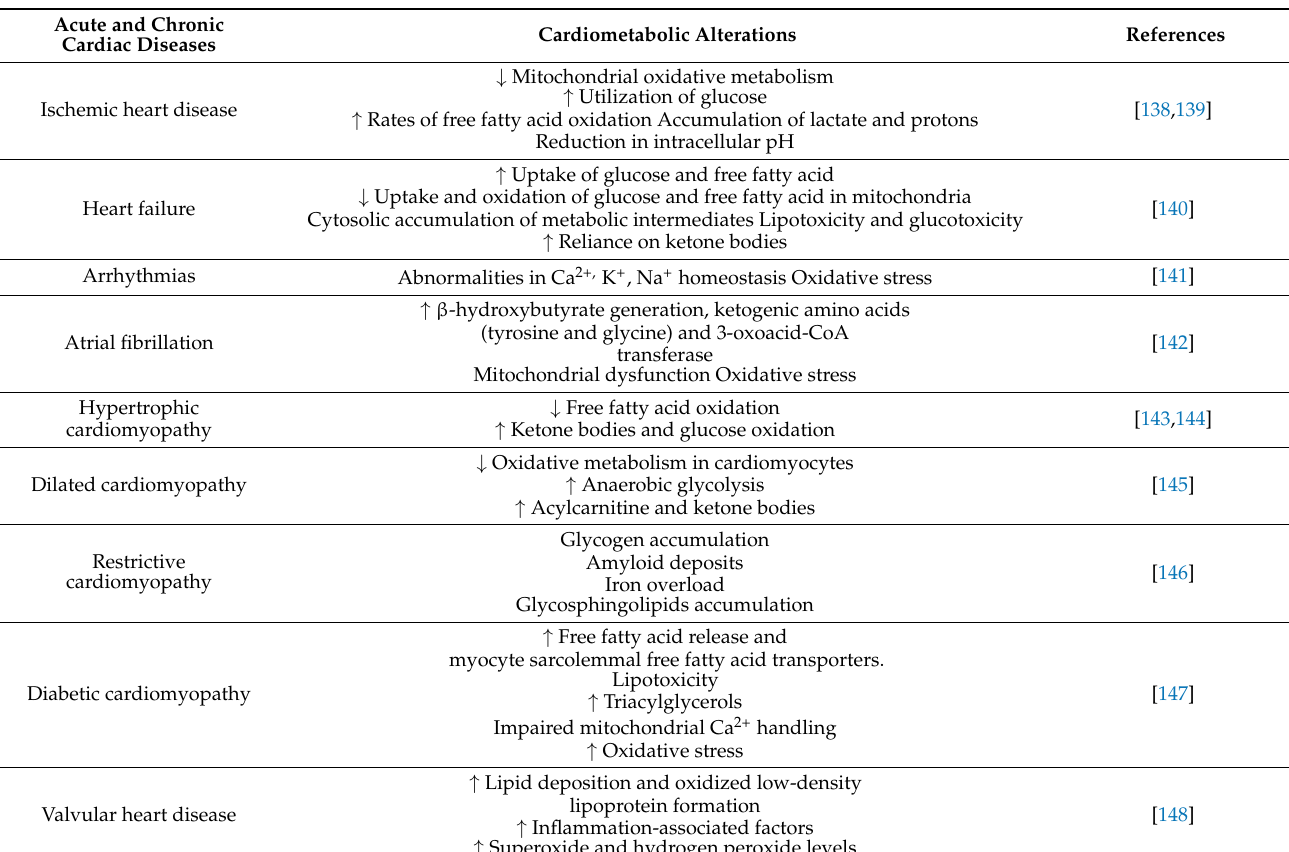
Table 2. Cardiometabolic alterations in cardiac